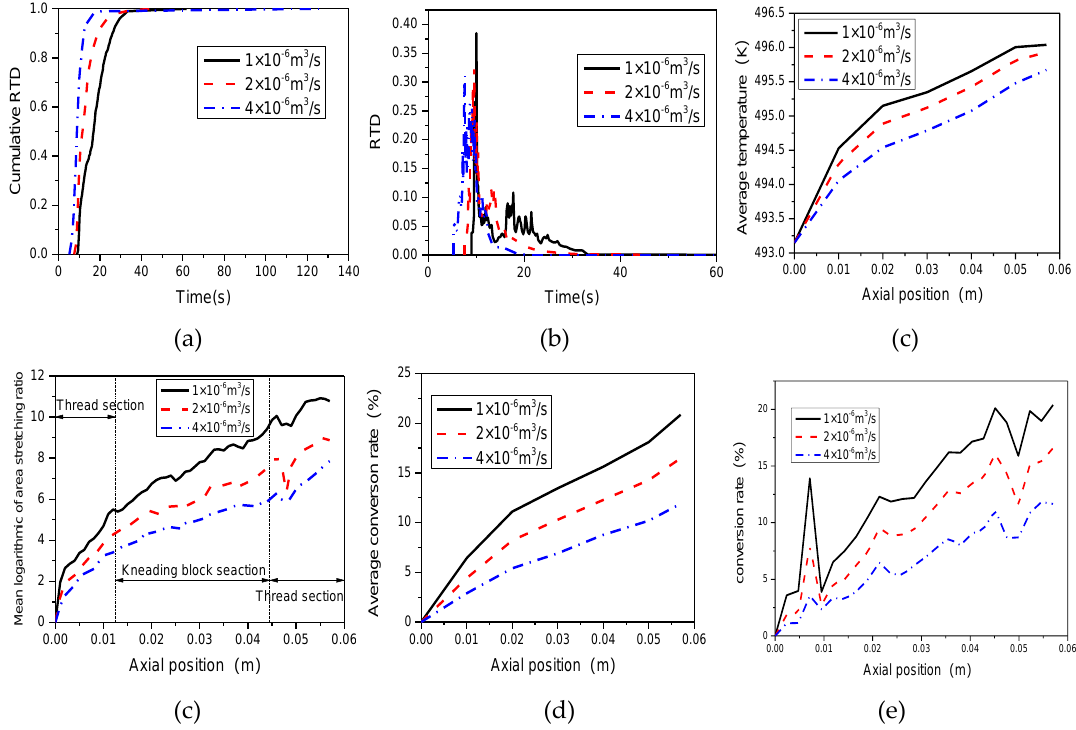
Figure 14. Effect of inlet flow rate on ( a ) cumulative RTD; ( b ) RTD; ( c ) logarithmic of area stretching; ( d ) temperature; ( e ) conversion rate; ( f ) local conversion at Line 2.